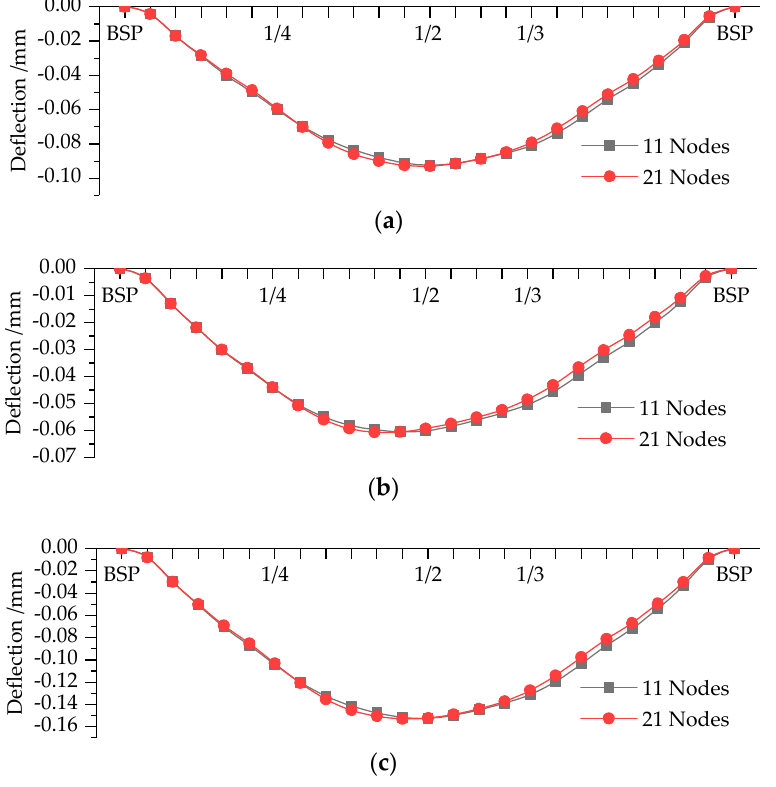
Figure 10. Bridge deflection curves modeled by Kriging method: ( a ) Case 1; ( b ) Case 2; and ( c ) Case 3. Table 4. Deflection results measured by dynamic test method (unit: mm)